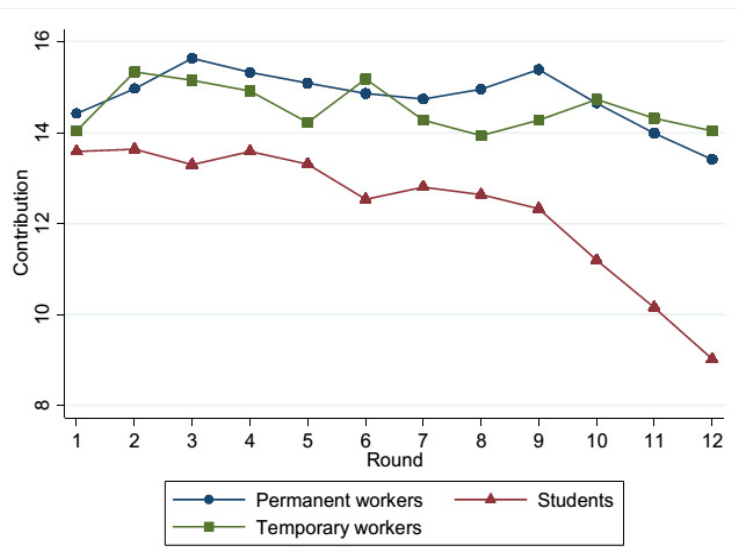
Figure 2. Evolution of average contributions over time (students, permanent, and temporary workers).